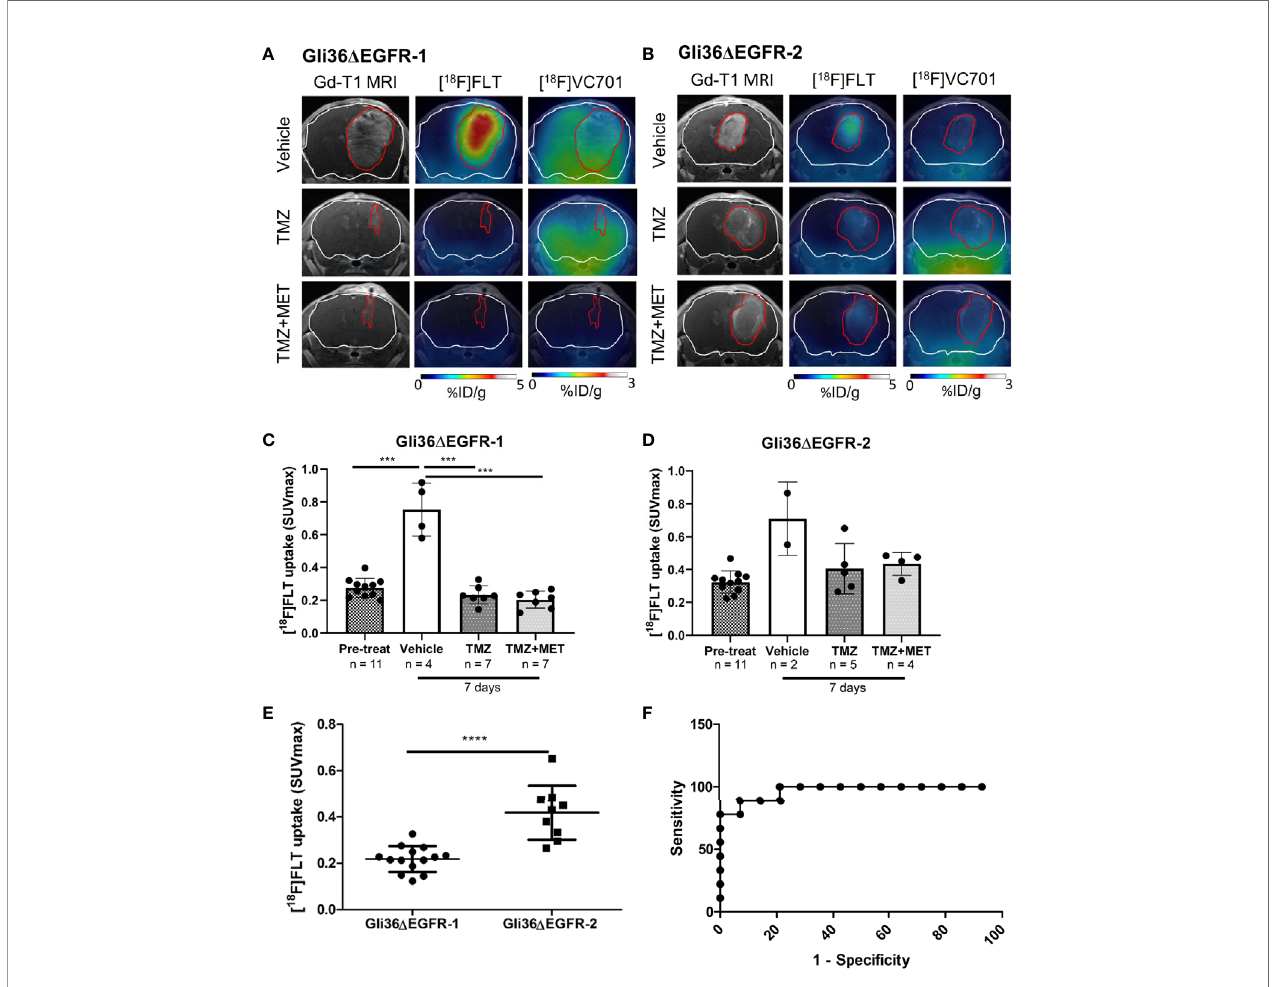
FIGURE 4 | [ 18 F]FLT uptake distinguished between TMZ-sensitive and – resistant tumors. Representative Gadolinium-T1w MRI images and their fusion with PET images for [ 18 F]FLT and [ 18 F]VC701 of Gli36 D EGFR-1 (A) and Gli36 D EGFR-2 tumor-bearing mice (B) after 7 days of vehicle, TMZ, and TMZ+MET treatment. The white line indicates the brain and the red one indicates the tumor area depicted by MRI. [ 18 F]FLT uptake expressed as SUVmax in Gli36 D EGFR-1 (C) and in Gli36 D EGFR-2 (D) tumor-bearing mice before and after 7 days of treatment. One-way ANOVA analysis followed by Tukey ’ s multiple comparison test was performed, ***p < 0.001. In the bottom part of both graphs, the sample size for each group is indicated. (E) , After 7 days of treatment with TMZ or TMZ+MET, mice with TMZ-resistant tumors showed a signi fi cant increase of [ 18 F]FLT uptake compared to TMZ-sensitive ones. Unpaired t-test analysis was performed, ****p < 0.0001. (F) , ROC analysis of [ 18 F]FLT SUVmax for prediction of different response to TMZ therapy. Optimal cut-off point was de fi ned for [ 18 F]FLT as 0.3295 (77.8% sensitivity; 100% speci fi